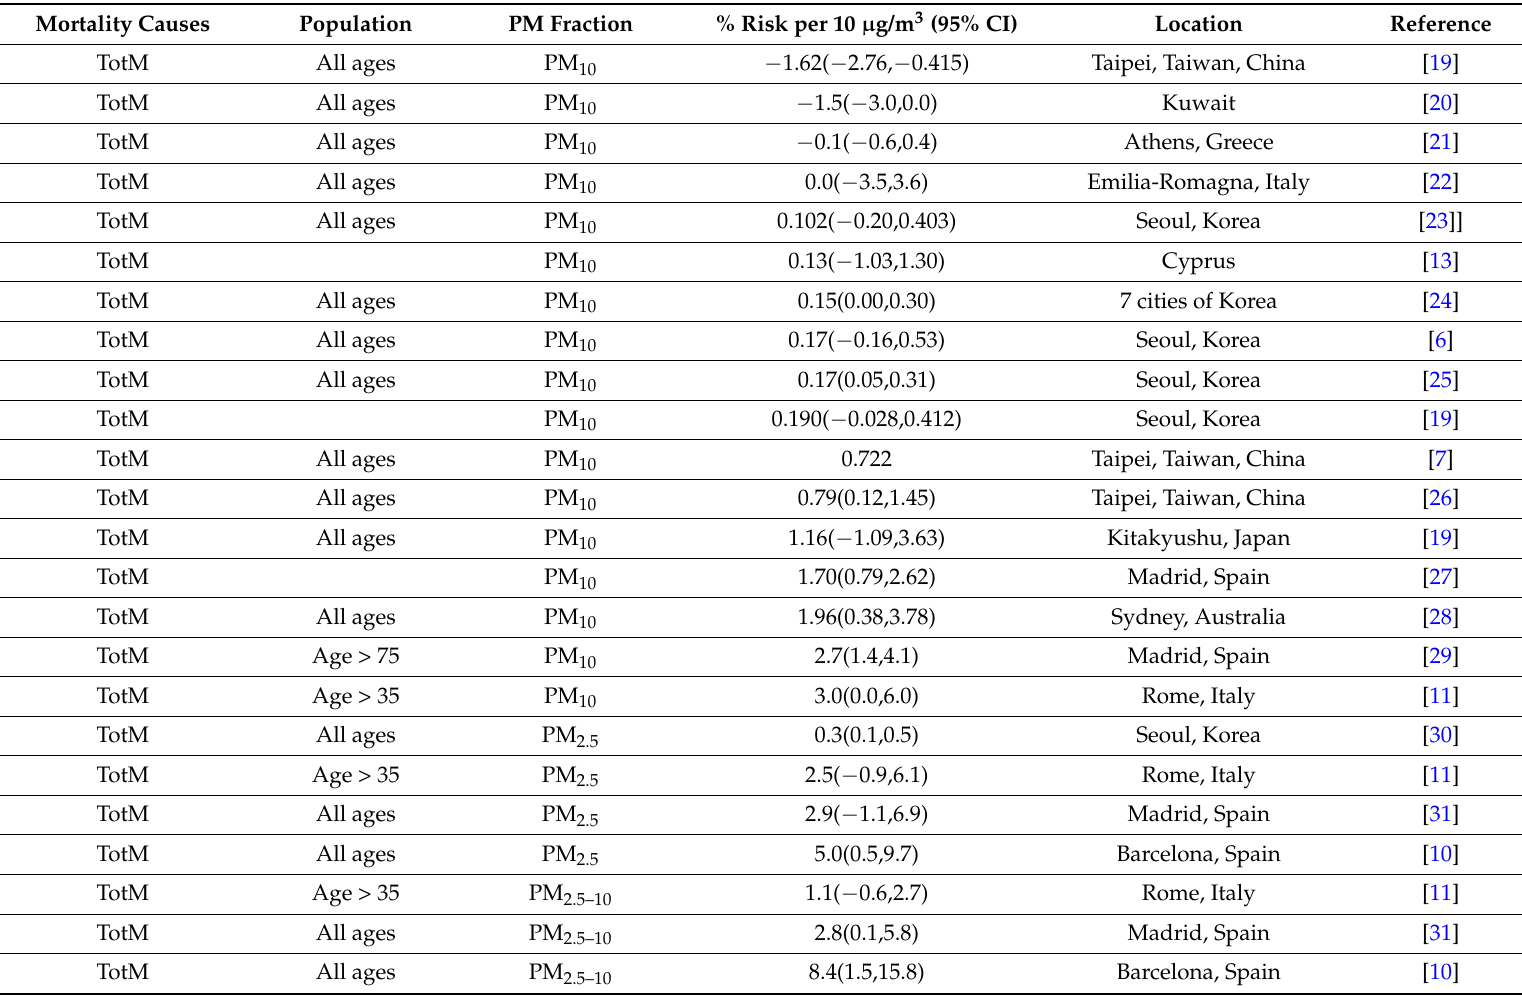
Table 1. The quantitative results for human mortality effects of desert dust particles with different aerodynamic